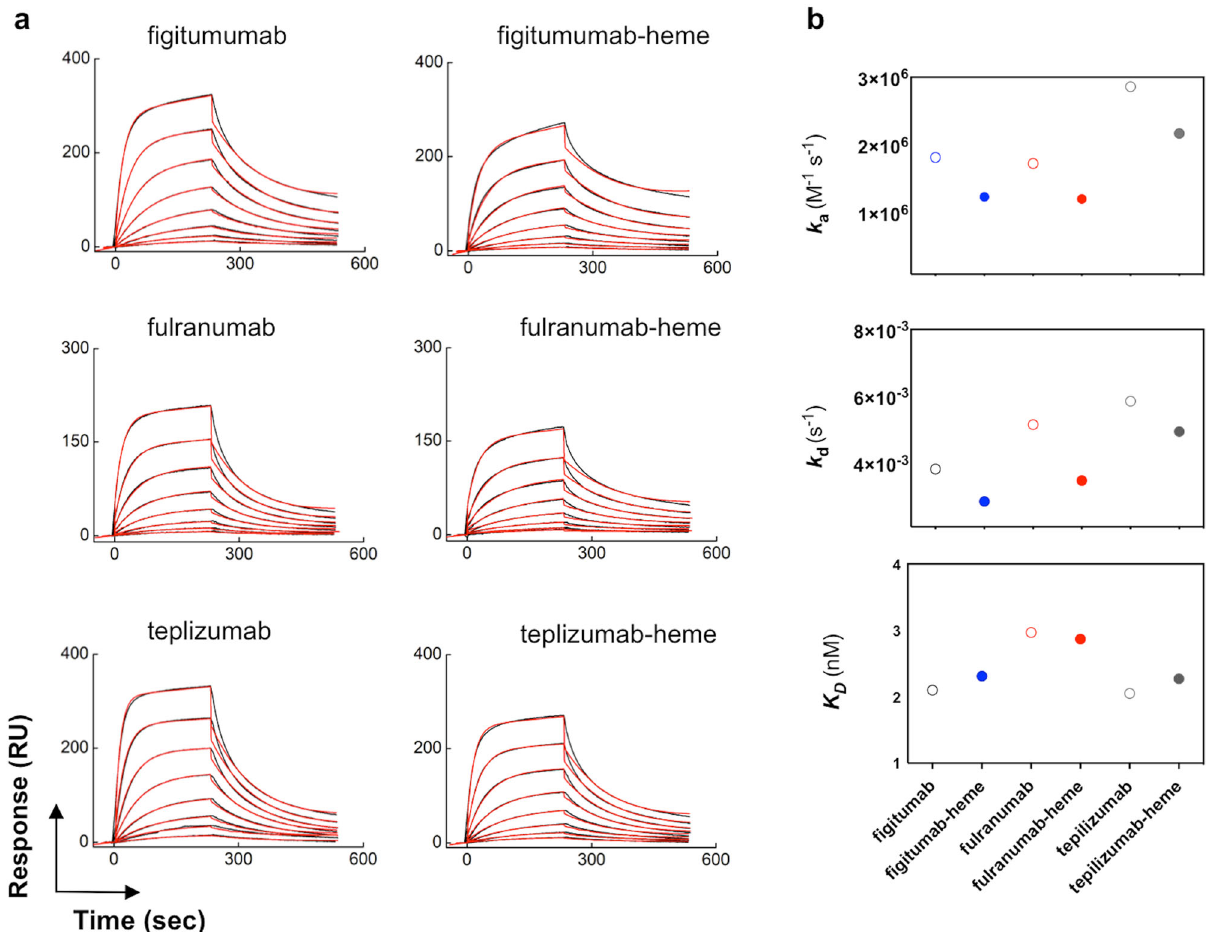
Fig. 4 Interaction of heme-binding antibodies with human FcRn. a Real-time binding pro fi les of selected heme-binding and heme-sensitive Abs to surface-immobilized human recombinant FcRn. The interaction analyses were performed with native and Abs exposed to an excess of hemin. The black lines depict the binding pro fi les obtained after injection of serial dilutions of monoclonal Abs, native, and after heme exposure (25 – 0.195 nM). The red lines depict the fi ts of data obtained by global analysis using the Langmuir kinetic model. All interaction analyses were performed at 25 °C. b Values of the kinetic rate constants of association (top panel), dissociation (middle panel), and equilibrium dissociation constant (bottom panel) for binding of native and heme-exposed monoclonal Abs to FcRn. The kinetics data were obtained after analyses of the real-time interaction pro fi les shown in ( a